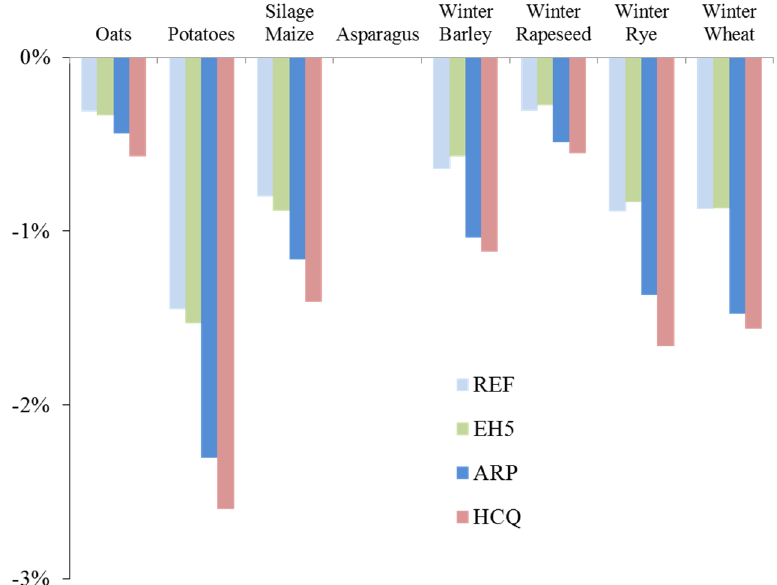
Figure 14. Change in average yearly additional crop yields by irrigation through irrigation management scenario SC_II to irrigation management scenario SC_I for multiple climate projections of the period